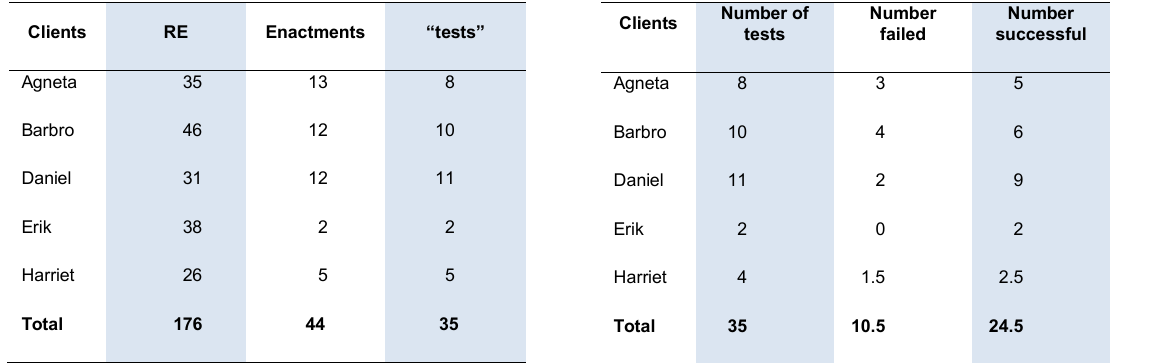
Table 6: The total number of REs and enactments for each of the clients and the number of enactments (”tests”) that agreed in each case with the corresponding individual CCRTs for the client in question.